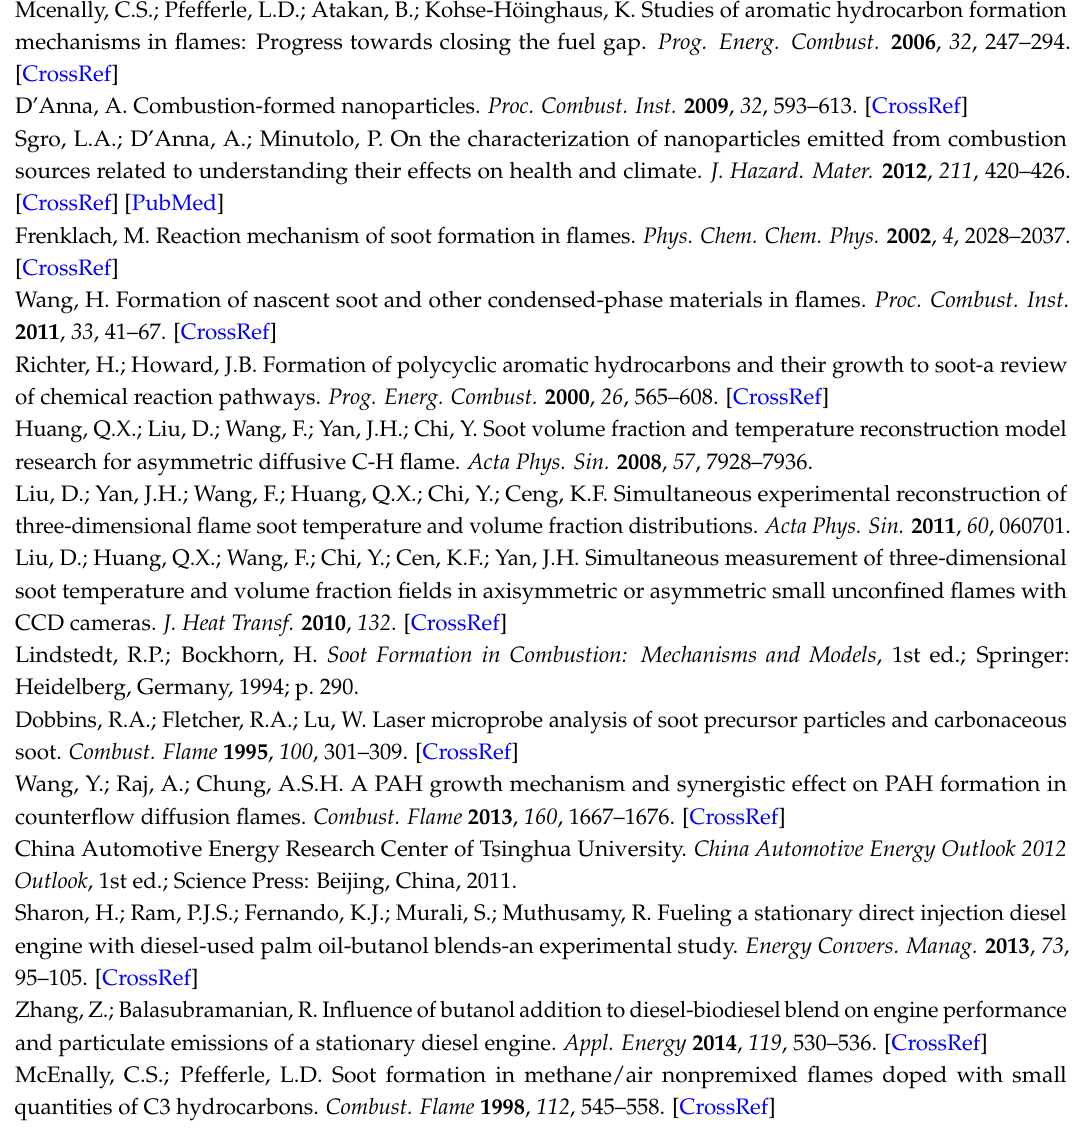
Figure S1: Aggregation morphology of nascent soot particles under four different conditions with collection time of 60 s: ( a ) pure ethylene; ( b ) 1-pentanol/ethylene; ( c ) 3-methyl-1-butanol/ethylene; ( d ) 2-methyl-1-butanol/ethylene. Figure S2: HRTEM images at higher magnification of nascent soot particles under four different flame conditions: ( a ) pure ethylene; ( b ) 1-pentanol/ethylene; ( c ) 3-methyl-1-butanol/ethylene; ( d )